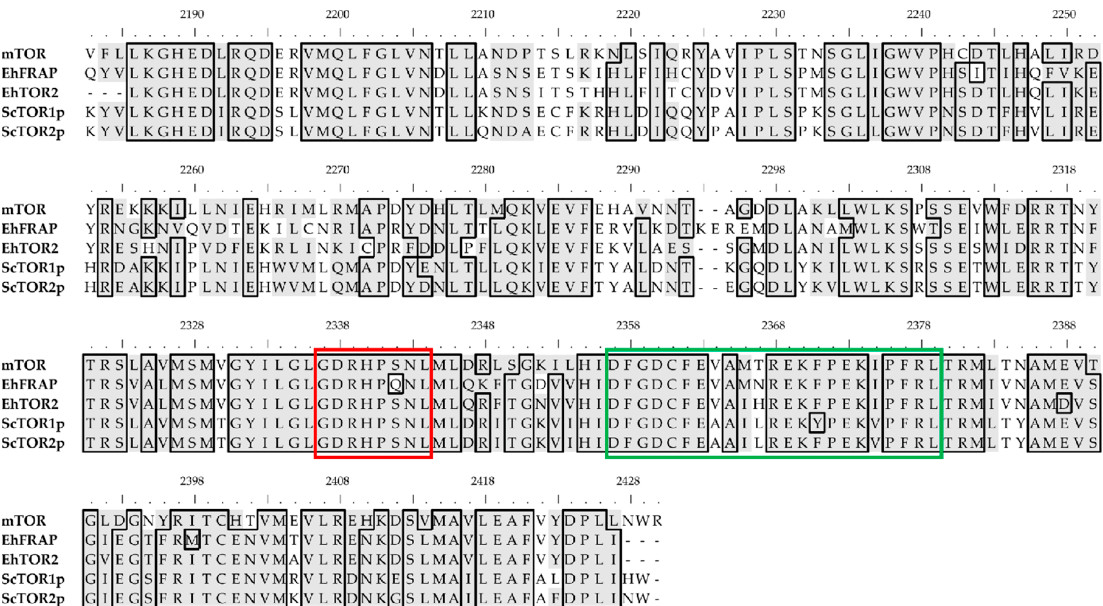
Figure 4. Multiple sequence alignment of PIKKc domains. Reference sequence (range): mTOR (2183–2430), Eh FRAP (2176–2422), Eh TOR2 (2019–2260), Sc TOR1p (2120–2366), and Sc TOR2p (2124–2370). The sequence of functional loops is within colored boxes: catalytic (red) and activation (green). Similar/identical residues, reference sequences, and top-ruler numbers are as described in Figure